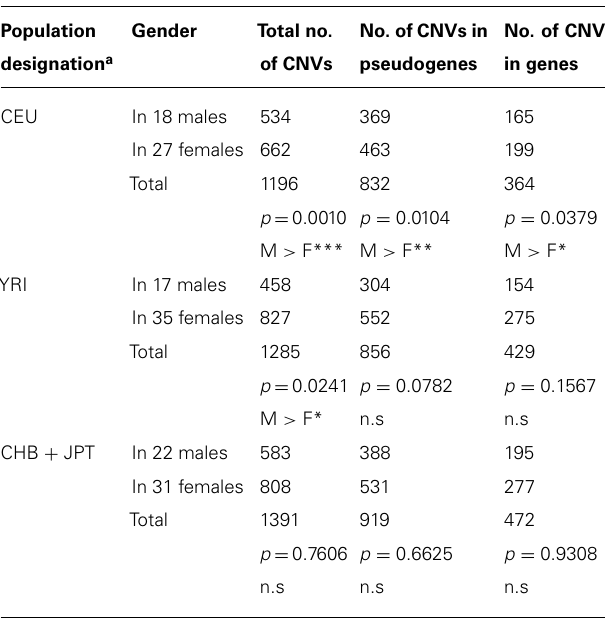
Table 3 | Gender comparisons of the number of uncommon and common CNV variants of OR pseudogenes in three diverse